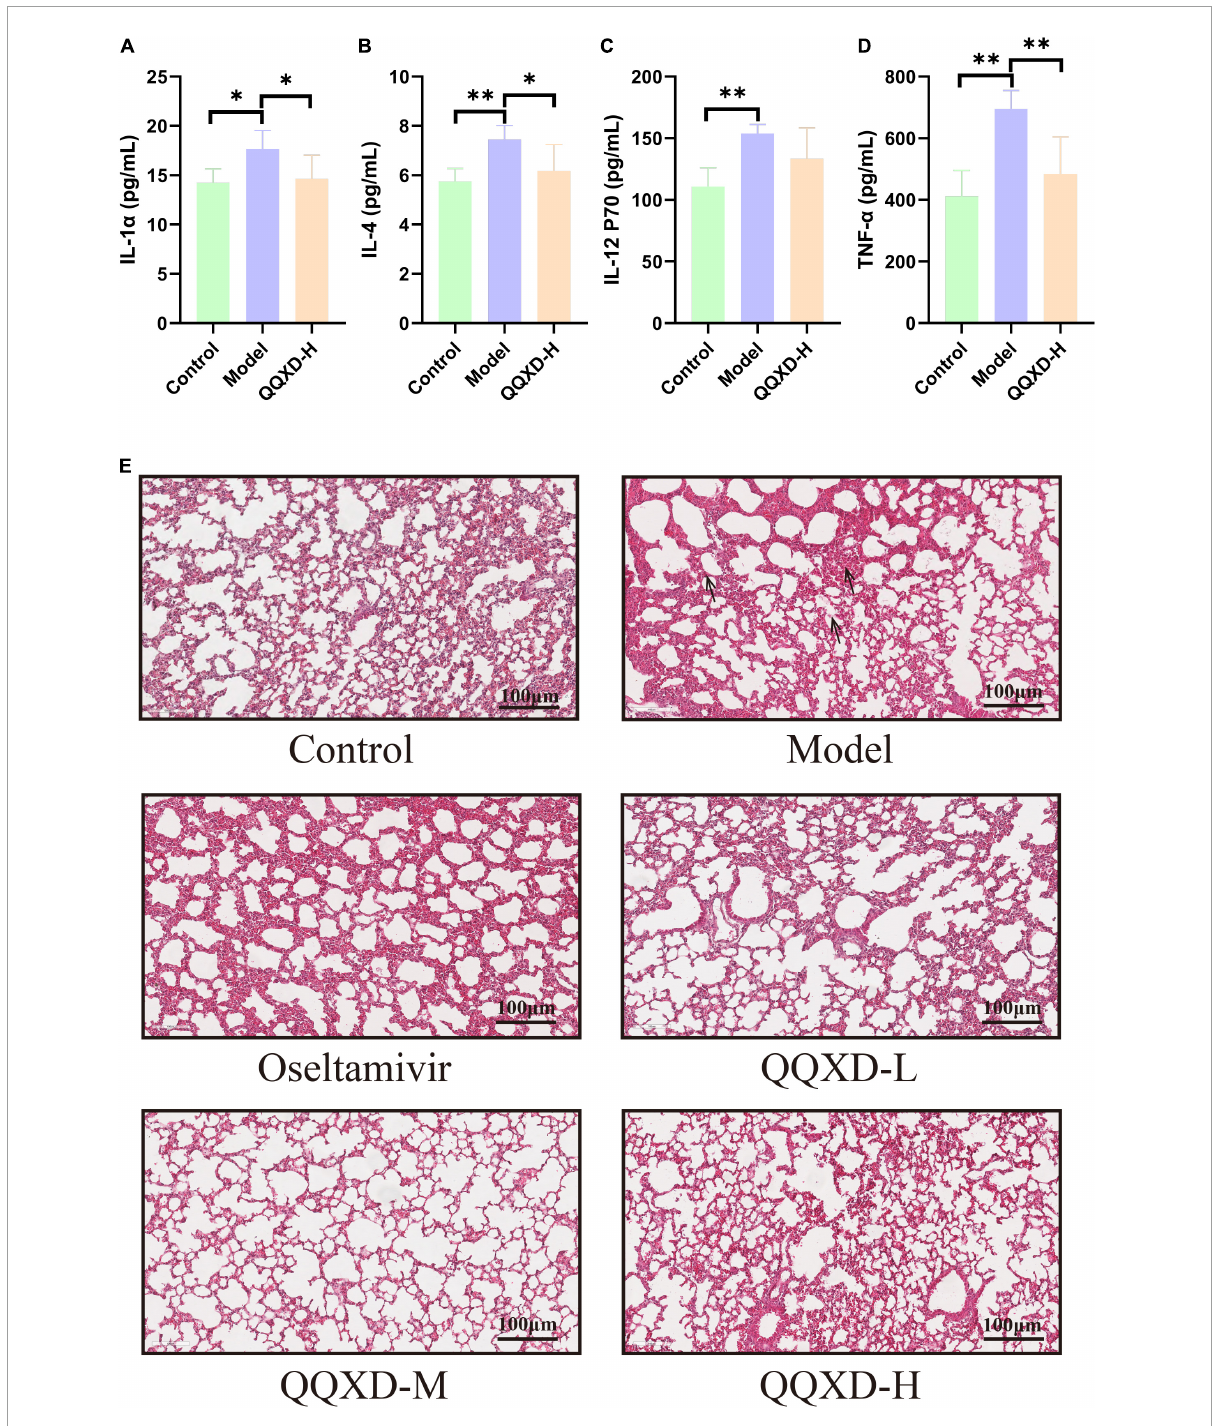
FIGURE3 Effects of QQXD on inflammatory factors and lung histopathology in influenza mice. (A) IL-1 α . (B) IL-4. (C) IL-12(P70). (D) TNF- α . (E) Hematoxylin-eosin staining of lung tissue; bar = 100 µ m. * p < 0.05, ** p < 0.01.